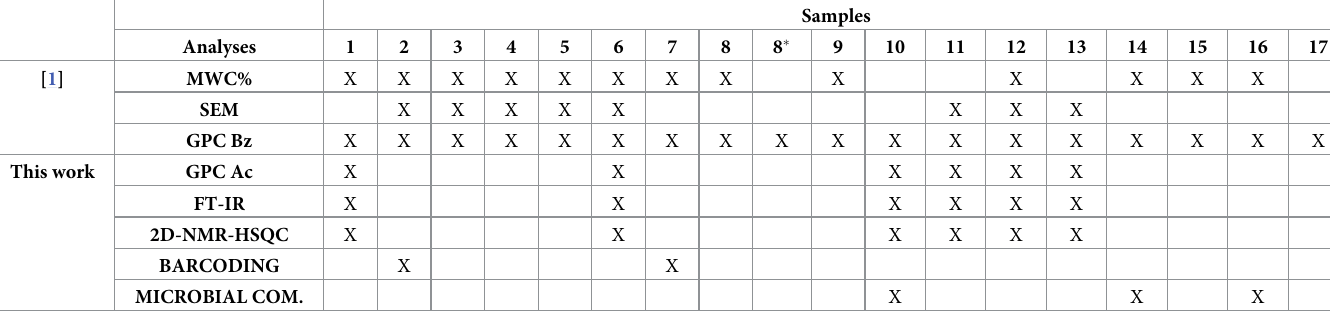
Table 1. Summary of the procedures performed on the San Marco canal lock gates in this work and in [1].